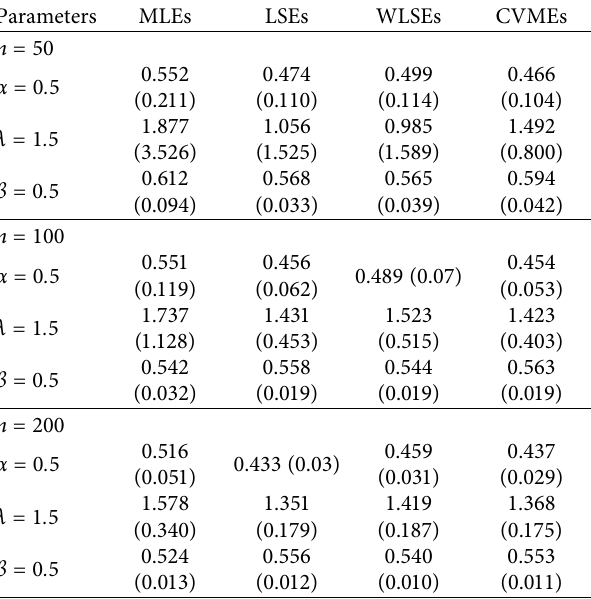
Table 2: The mean values and MSEs of the TIHLIW